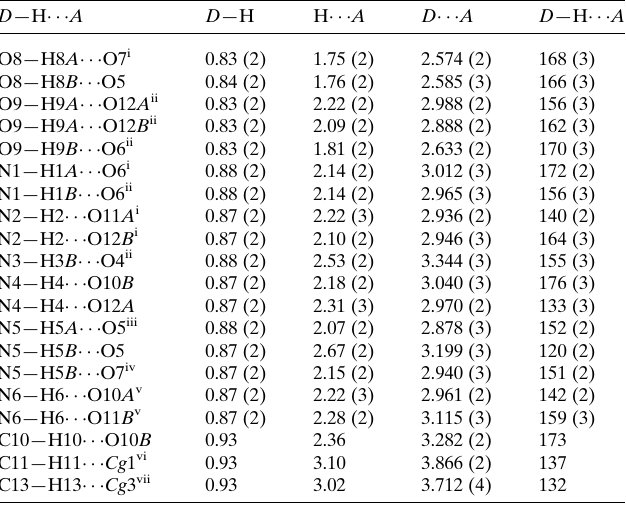
Table 1 Hydrogen-bond geometry (A˚ , (cid:4)